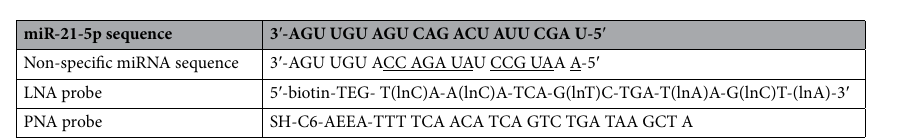
Table 2. The miRNA, LNA and PNA sequences used in this study. The sequence on the first row corresponds to the miR-21-5p sequence specific to pancreatic cancer. TEG is a 15-atom long linker (tetra-ethyleneglycol), while AEEA is a 9-atom glycol linker (8-amino-3,6-dioxaoctanoic acid). LNA modification sites in the sequence are represented by (ln).